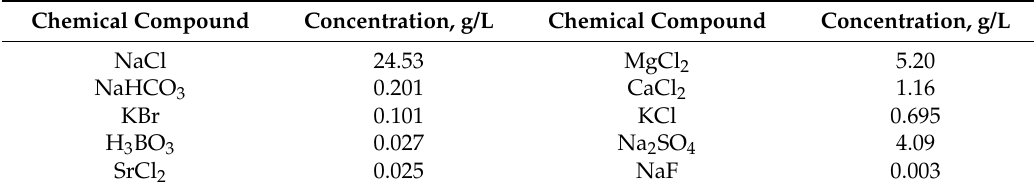
Table 2. Artificial seawater composition.